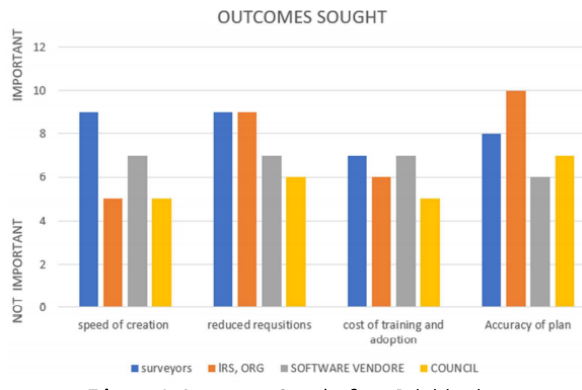
Figure 4 : Outcomes Sought from